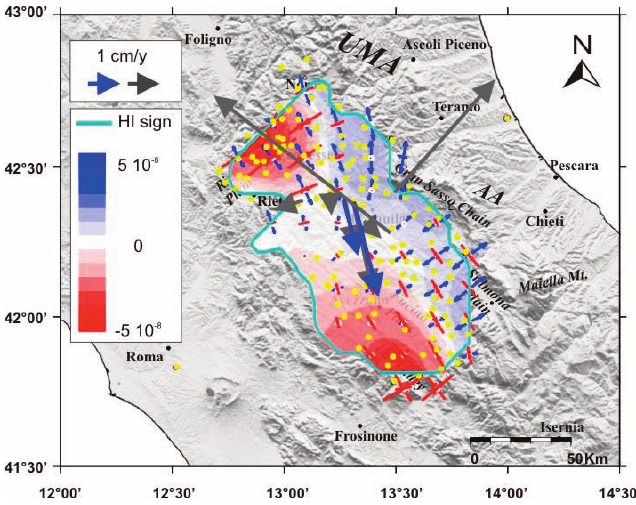
Figure 12. Change-in-area contour map from the 1999-2007 corrected velocity fields and the displacements caused by April 6, 2009, destructive earthquake. Computed velocities (cm/y; blue arrows) and data published by Anzidei et al. [2009] are also shown (gray